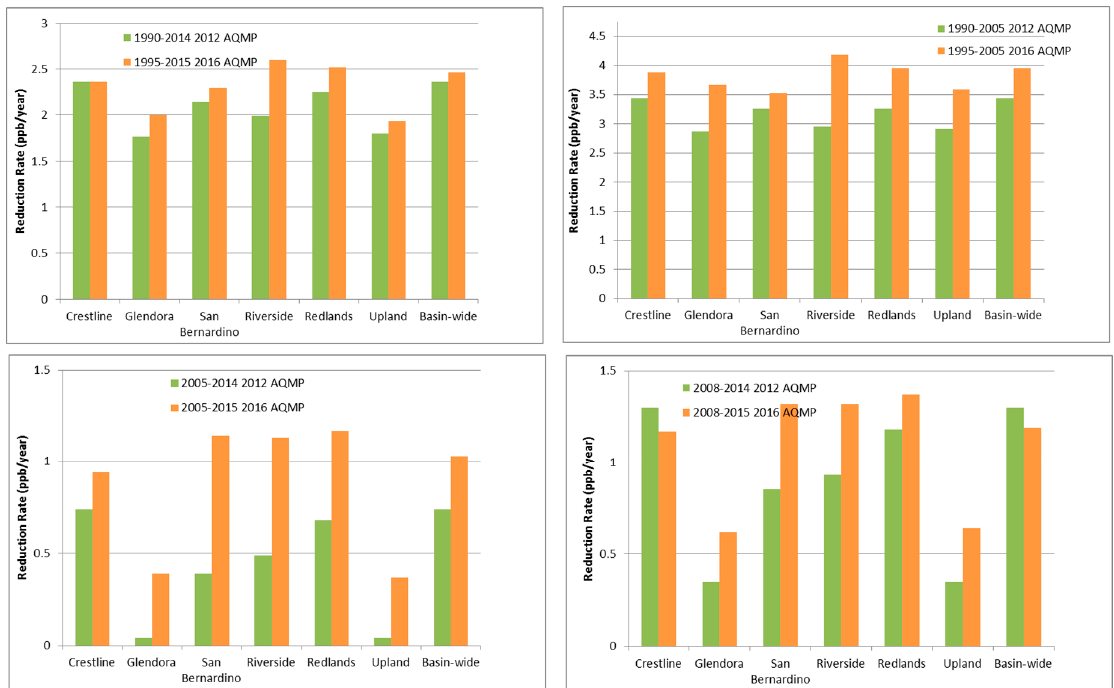
Figure 12. Comparison of 2012 AQMP and 2016 AQMP modeled reduction rates of 3-year ozone design values at selected monitors for the periods from 1990 to 2014 and 1995 to 2015 ( top left ), 1990 to 2005 and 1995 to 2005 ( top right ), 2005 to 2014 and 2005 to 2015 ( bottom left ), and 2008 to 2014 and 2008 to 2015 ( bottom right ).